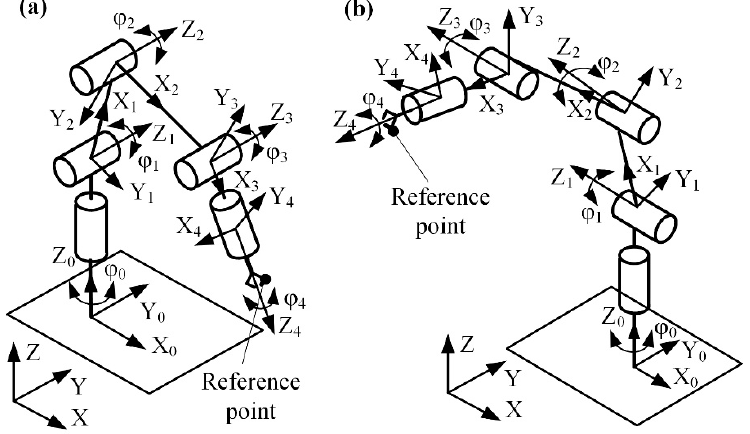
Figure 3. Position of the end-of-arm reference point: ( a ) start (measuring) position; ( b ) endpoint of the trajectory.